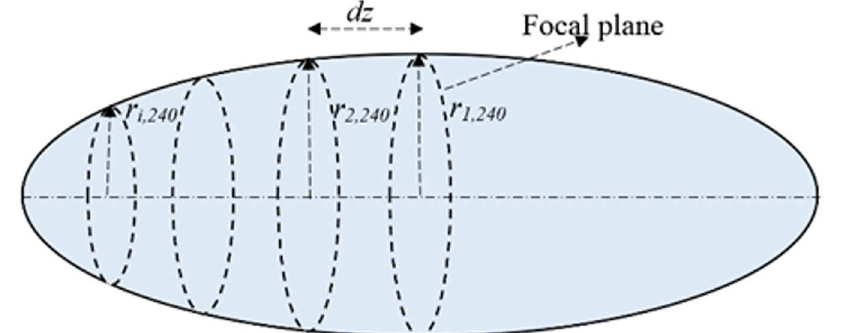
Fig 7. Discretization of lesion volume into truncated